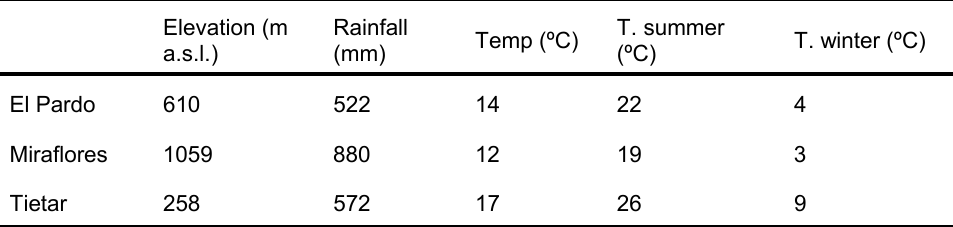
Environmental Conditions at the Three Experimental